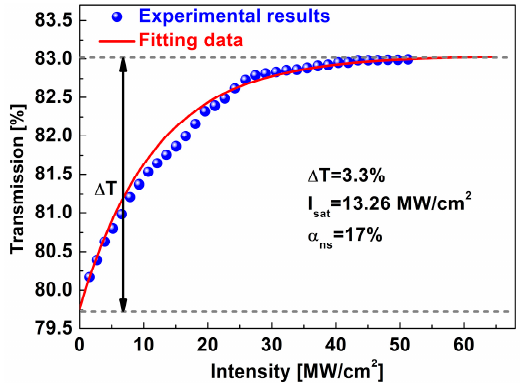
Figure 4. Nonlinear saturable absorption of ZrS 2 -based SA.